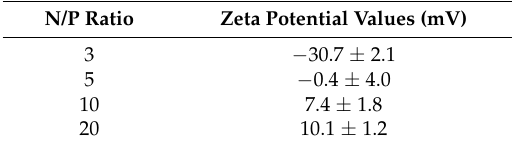
Table 1. Zeta potentials of polyplexes at the indicated